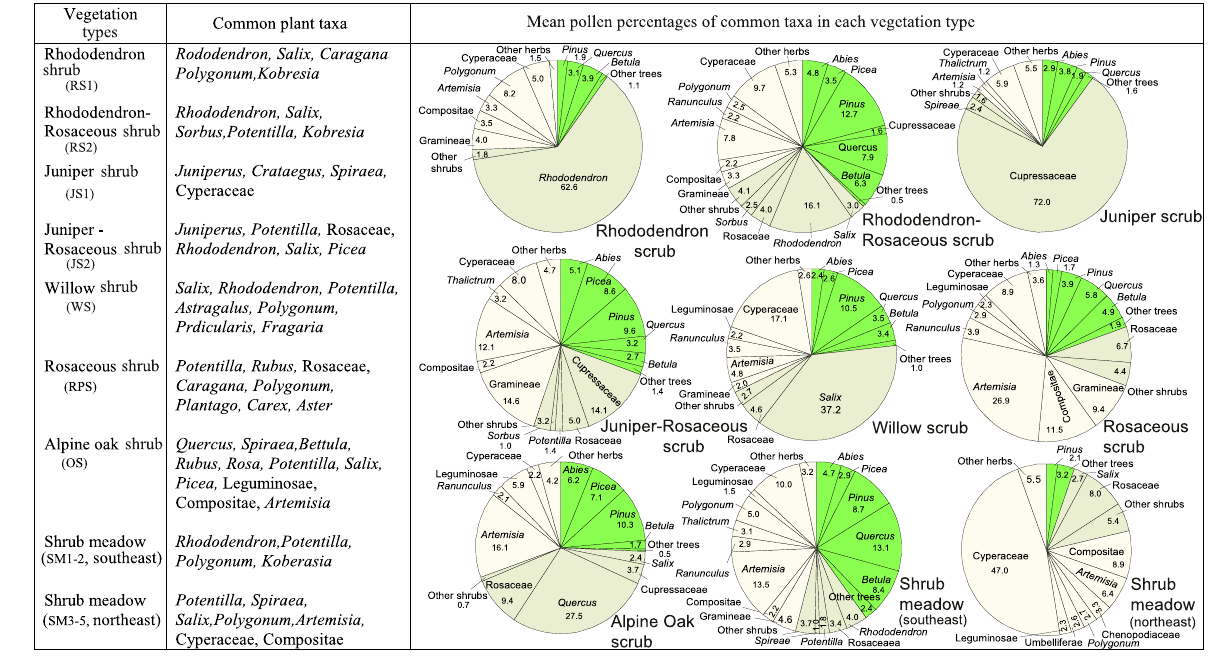
FIGURE 11 | Shrubland and shrub meadow types in the TP and their common plant taxa and representative pollen assemblages. Pie graphs in the right show the mean percentages of the common pollen taxa, calculated by averaging the pollen percentages of the corresponding taxa within each group. For Shrubland and shrub meadow type classi fi cation, see Figures 4 , 5